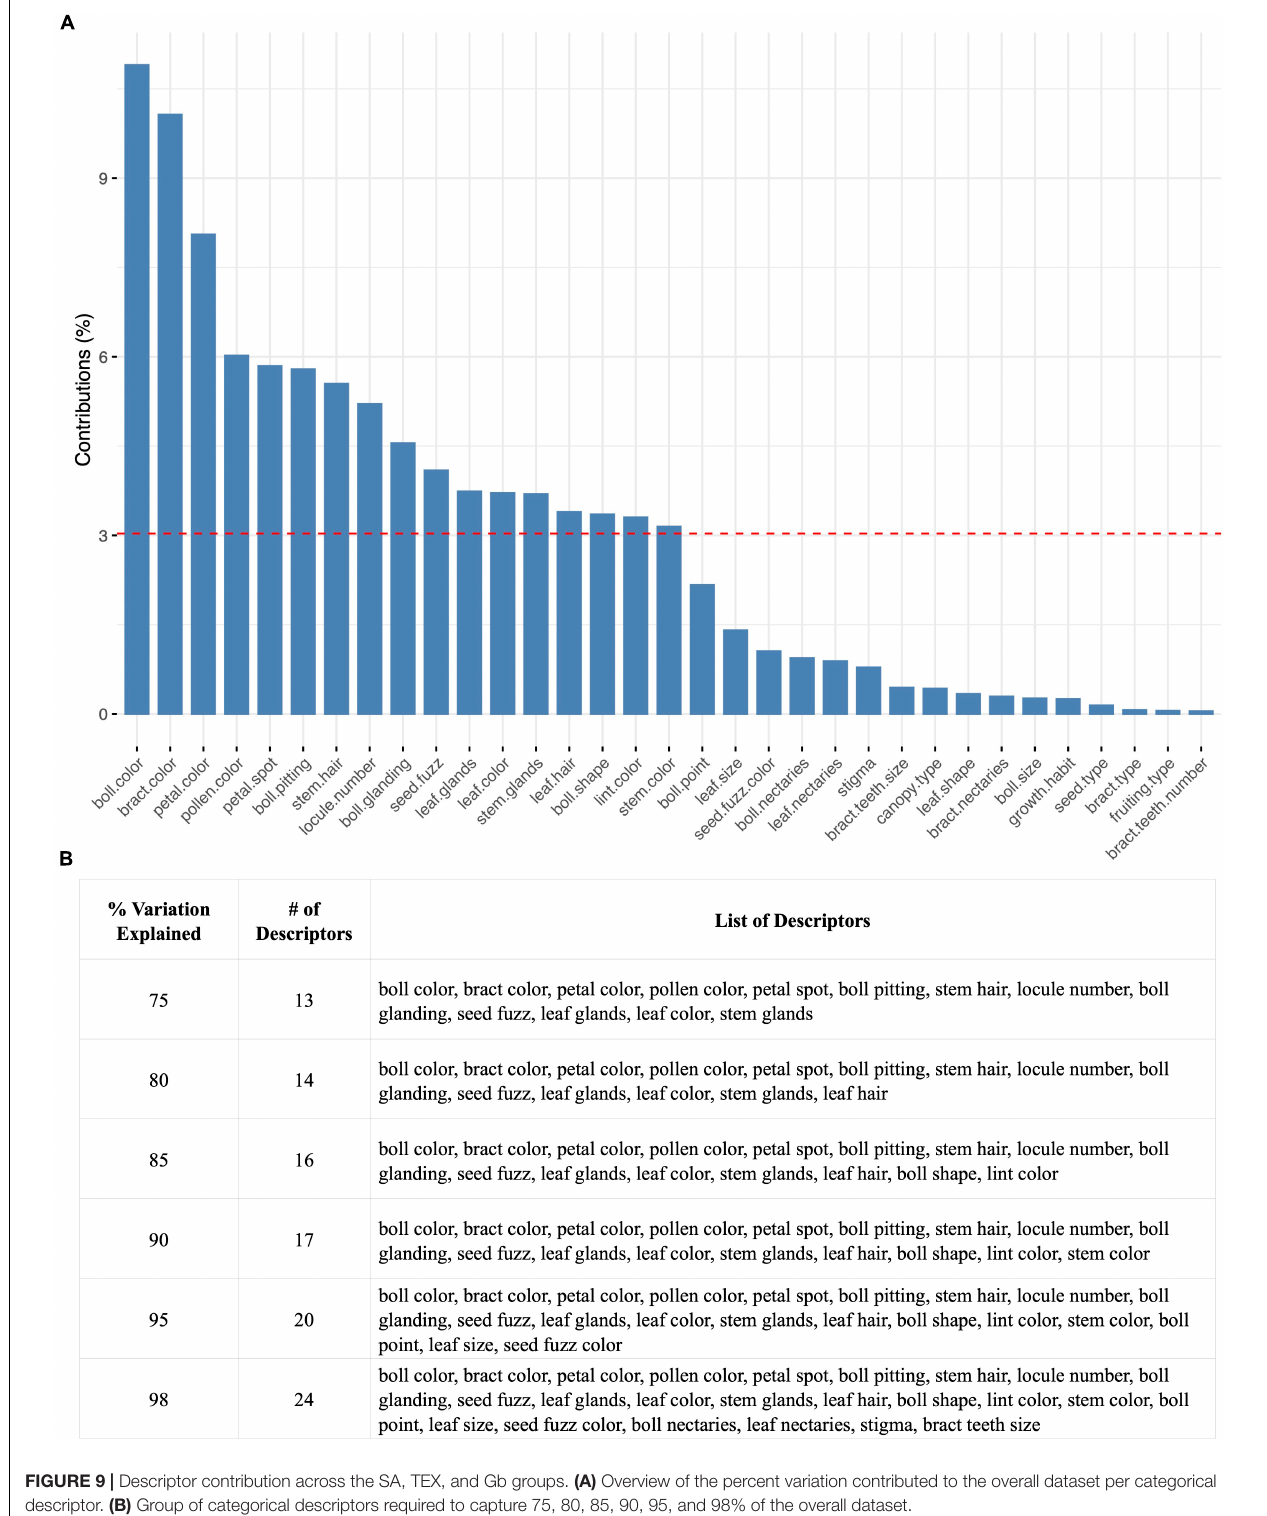
Frontiers in Plant Science |